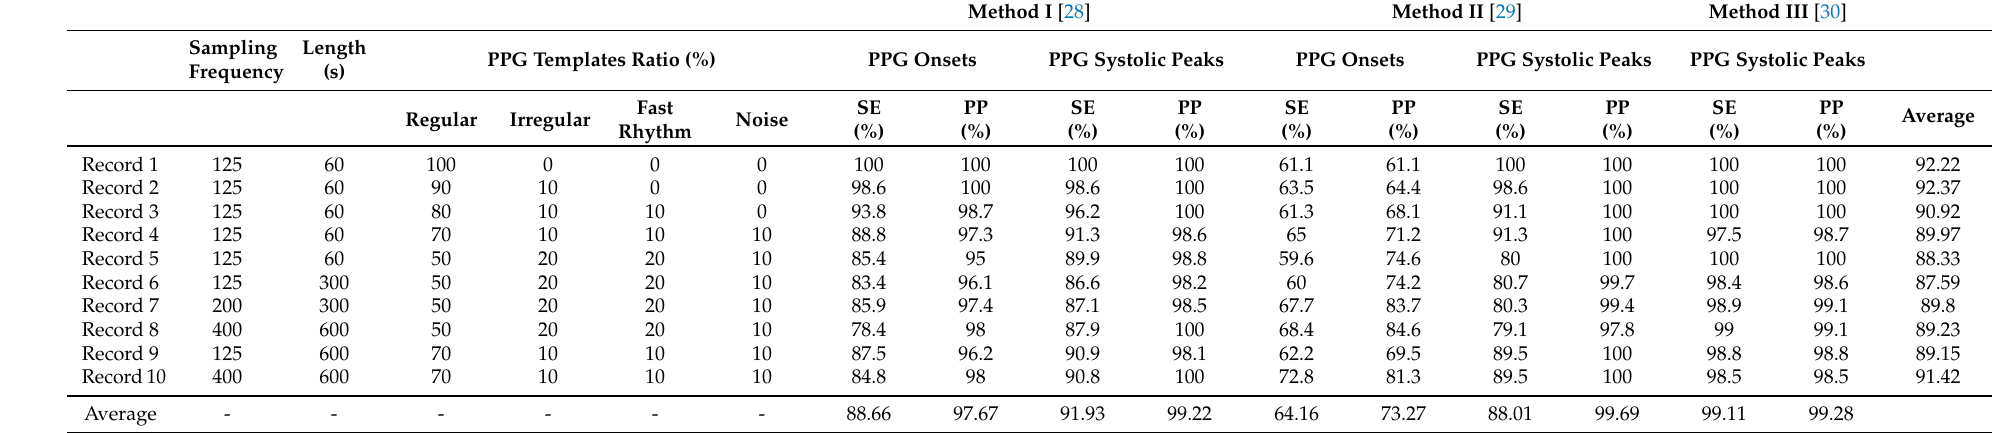
Table 2. Comparison of the accuracy of the feature extraction algorithms on different synthetic PPGs. ‘SE’ refers to the sensitivity of the algorithm, while ‘PP’ refers to the positive